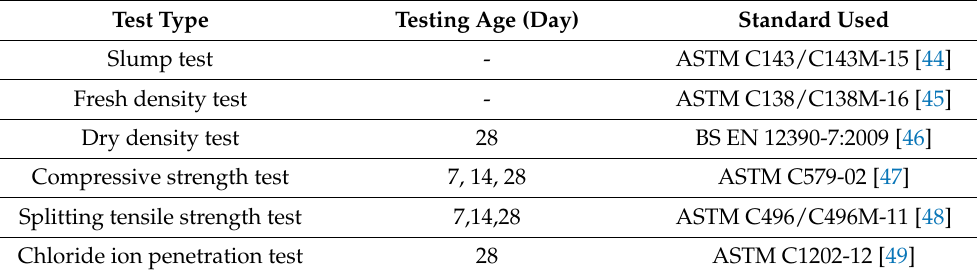
Table 3. Standard used for tests conducted on concrete